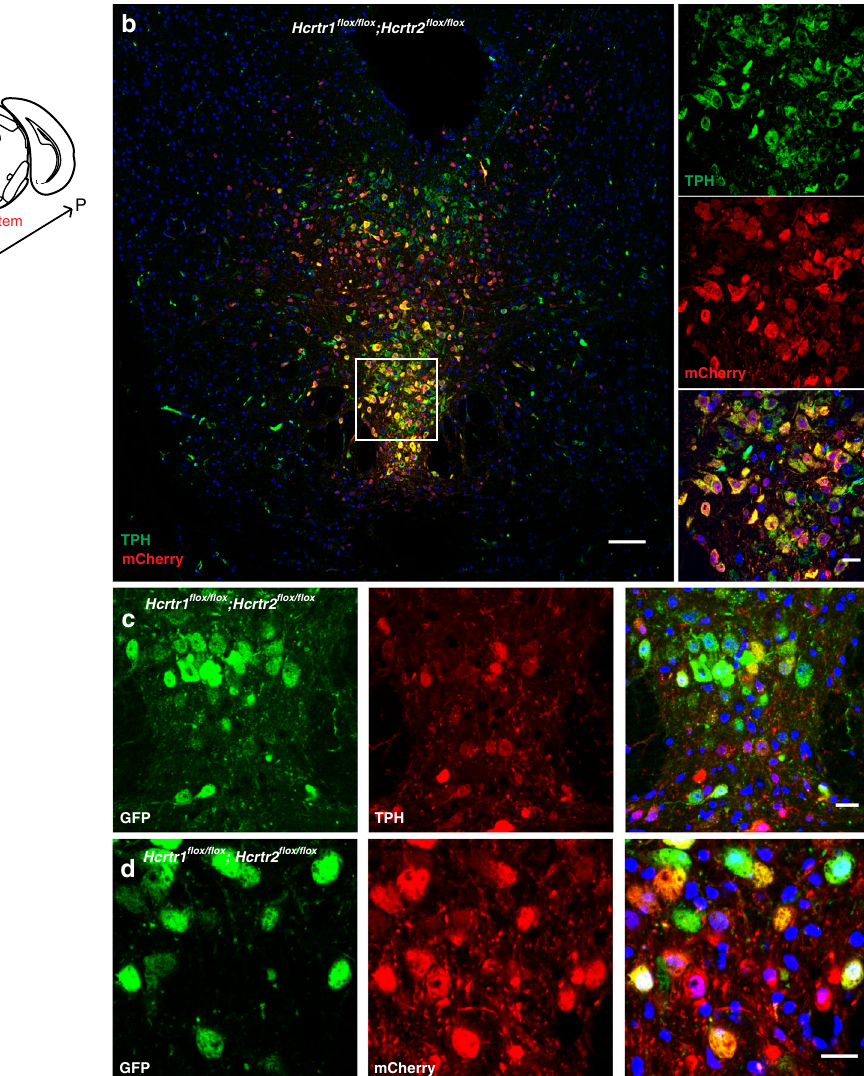
Fig. 4 Inactivation of Hcrtr1 & 2 in the DR. a Schematic fi gure depicting the experiment where the HCRT input (from posterior “ P ” to anterior “ A) to the dorsal raphe (DR) is disrupted. b Representative confocal image of the DR of Hcrtr1&2 double- fl oxed homozygous mice injected with AAV-EF1a-mCherry- IRES-Cre-WPRE and stained with mCHERRY (red) and TPH (green) antibodies. mCHERRY-positive cells (red) are highly co-localized with TPH-positive cells (green). Higher magni fi cation (×40, right). c , d GFP is expressed after Cre recombination. TPH-positive cells ( c middle red) transduced with Cre virus ( d middle red) are positive for GFP ( c and d , left green). Scale bars: b 100 μ m, rest 20 μ